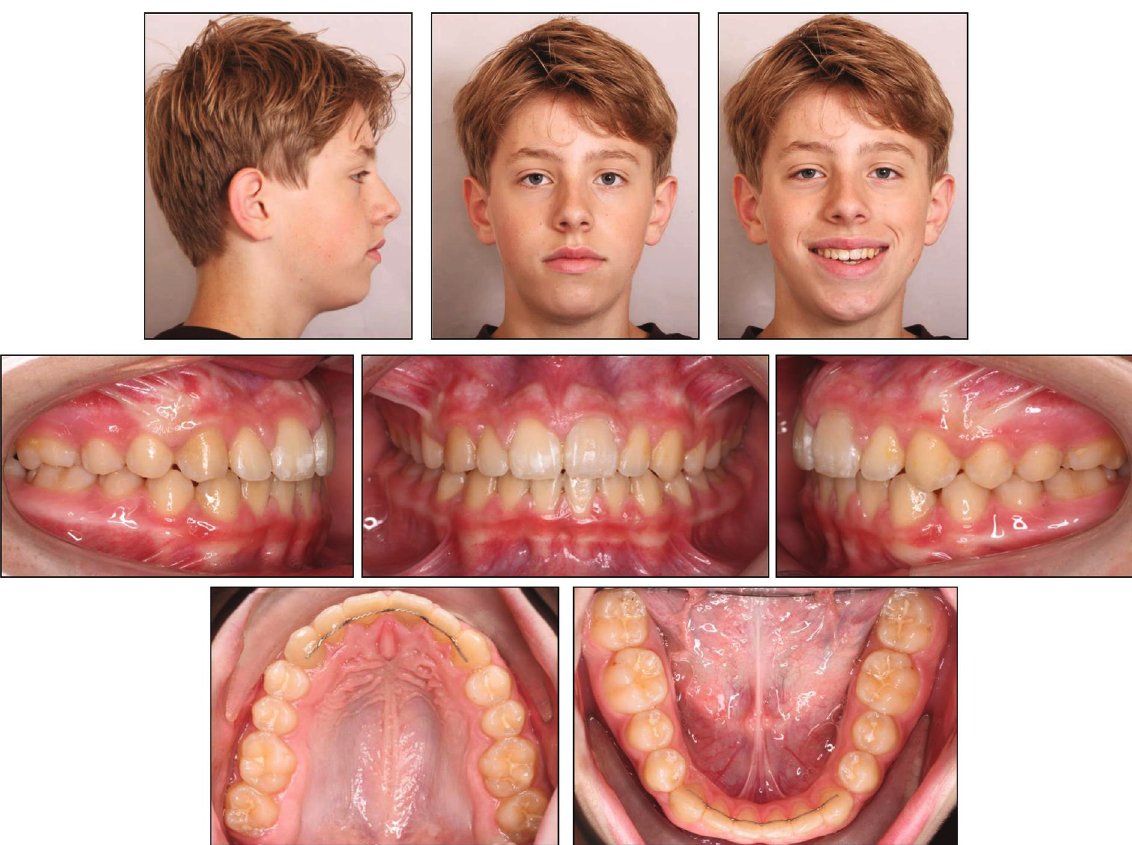
Figure 16: The patient ’ s facial and intraoral photographs taken one year after treatment of the patient at the age of 14 years and ten